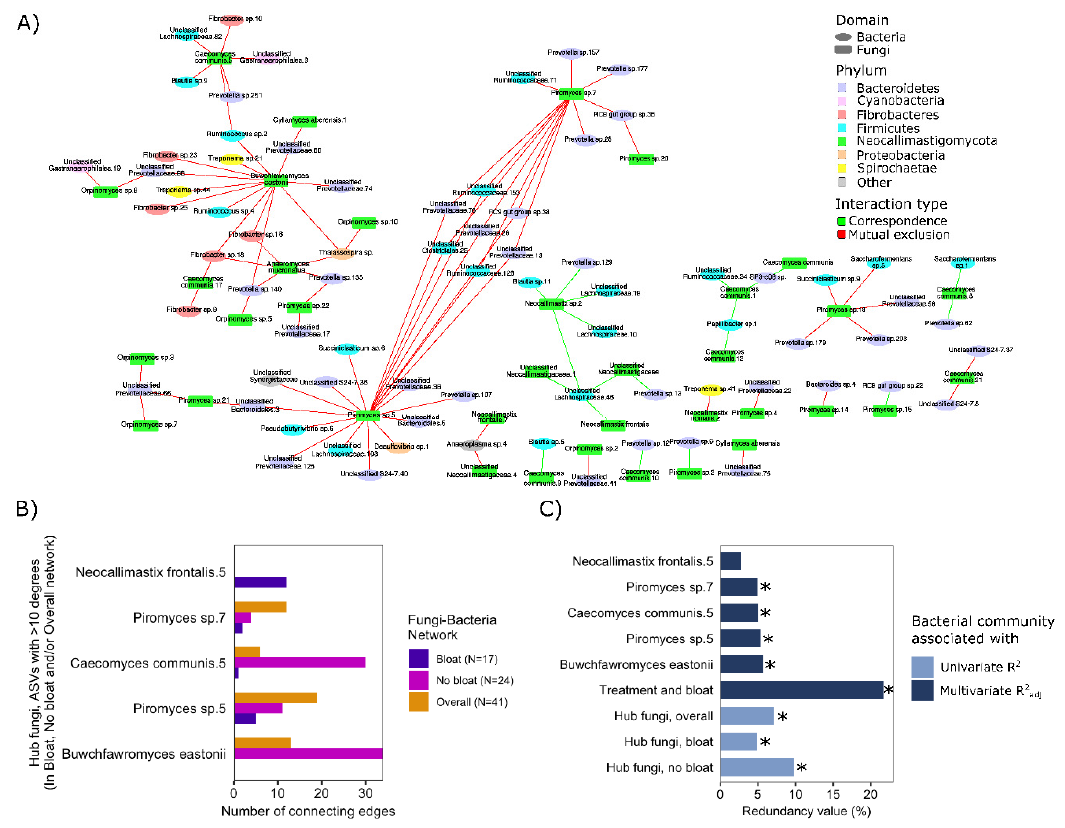
Figure 3. Co-occurrence patterns between anaerobic rumen fungi and bacteria and association of hub fungal ASVs with bacterial composition. ( A ) The overall network showing associations between fungi and bacteria among all steers and across all treatments (separate networks showing fungal-bacterial associations in bloated and non-bloated steers can be found in Supplementary Figure S2A,B, respectively). Nodes (representative of ASVs) are colored based on originating phyla, and edges (representing significant co-occurrence / co-exclusion relationships) are colored based on the type of relationships (red = negative relationship or mutual co-exclusion and green = positive relationship or co-occurrence). Only edges showing significant associations (P (FDR) < 0.05) supported by at least three measures of correlation and / or dissimilarity are included in the network (Spearman rank correlation, Kendal correlation, Bray–Curtis and Kullback–Leibler dissimilarity). ( B ) Potential hub fungi ASVs identified across all networks (non-bloated steers, bloated steers and overall networks). The number of connecting edges indicates the number of associations each fungi ASV has with bacterial ASVs in each network. The y-axis shows ASVs with the most connecting edges (potential hub fungi) for each of the three networks. ( C ) Redundancy analyses showing the contribution of hub fungi ASVs to observed variation in overall bacterial composition (Redundancy value using center log-ratio proportions of fungal ASVs). Individual hub fungi were assessed in a single redundancy model adjusted for dietary treatment and bloat status (top six bars colored in dark blue). Three additional models (bottom three bars colored in light blue) show the combined contribution of all 10 hub fungi to observed variations in overall bacterial composition of the rumen content of all steers (Hub fungi, overall), overall bacterial composition of the rumen content of non-bloated steers (Hub fungi, no bloat), and overall bacterial composition of the rumen content of bloated steers (Hub fungi, bloat). * indicates p < 0.05.